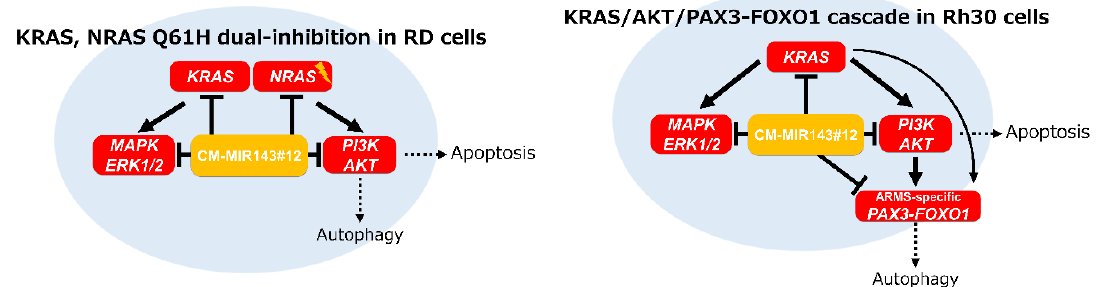
Figure 7. Schematic diagram showing the mechanism of growth inhibition by the ectopic expression of CM-MIR143#12 in RD and Rh30 cells.